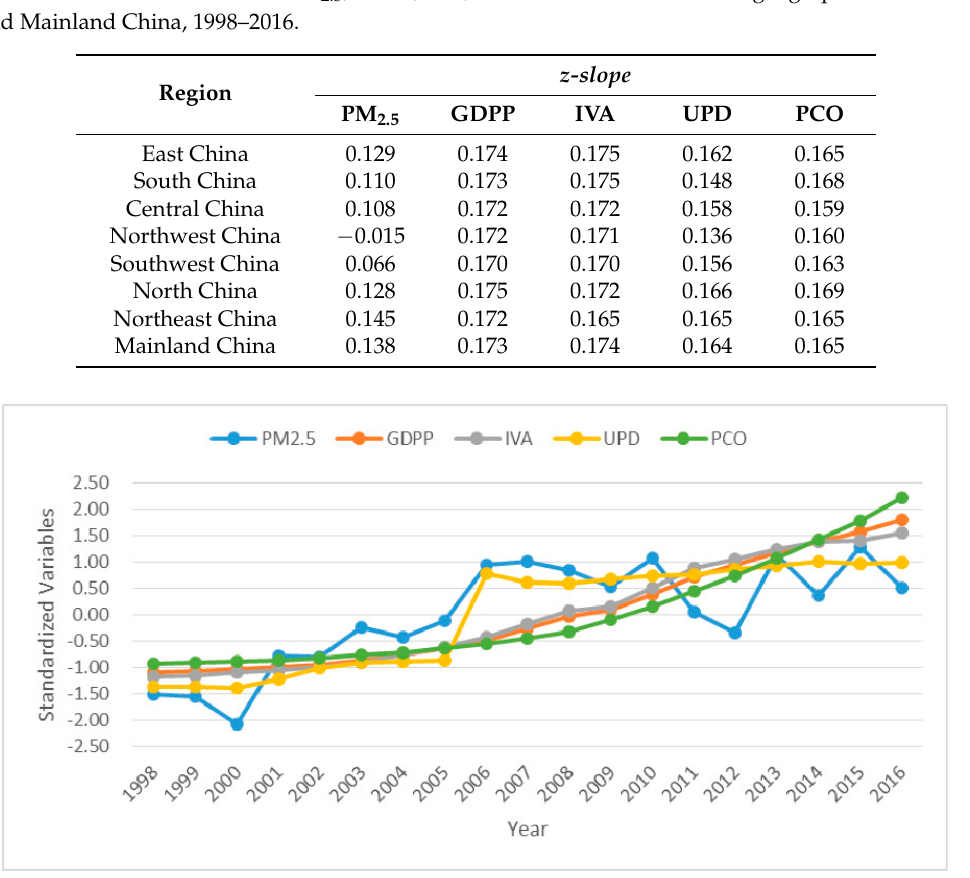
Figure 2. Temporal variations of standardized PM 2.5 , GDP per capita (GDPP), industrial added values (IVA), urban population density (UPD) and private car ownership (PCO) in Mainland China 1998 to 2016.